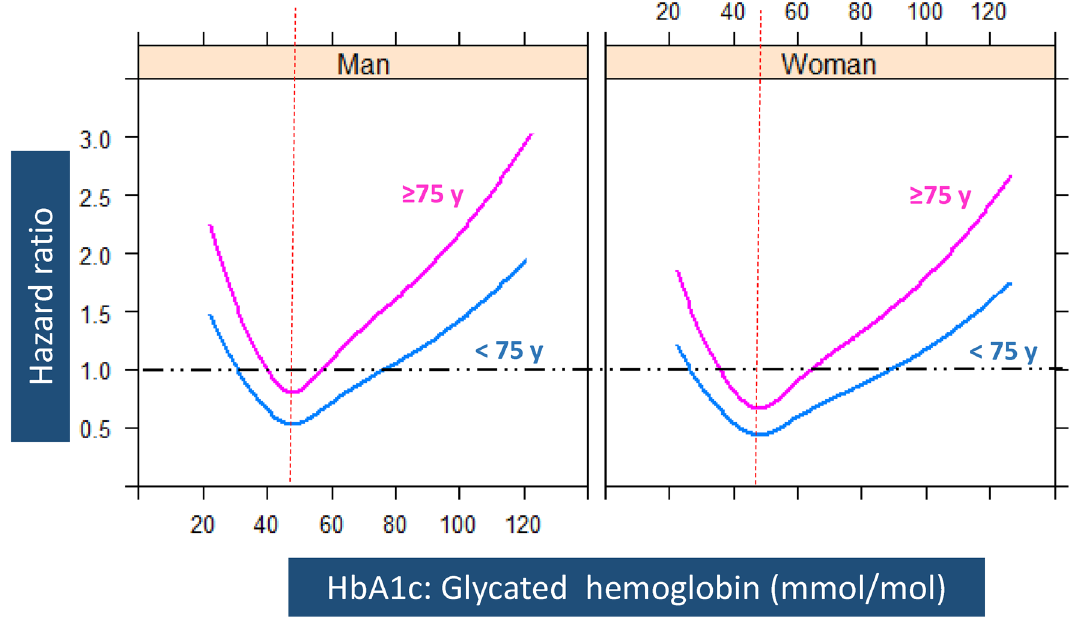
Figure 1. Representation of relationship between HbA1c* values and the Hazard Ratio of Myocardial Infarction, according to sex and age group. *Adjusted for HDL-cholesterol, DBP and albuminuria (Table 2). Dashed red lines indicate the hemoglobin value associated to a lower risk of AMI. Pink lines represent the adjusted effect of HbA1c on the risk of AMI in patients aged 75 years or older. Blue lines represent the adjusted effect of HbA1c on the risk of AMI in patients under 75 years of